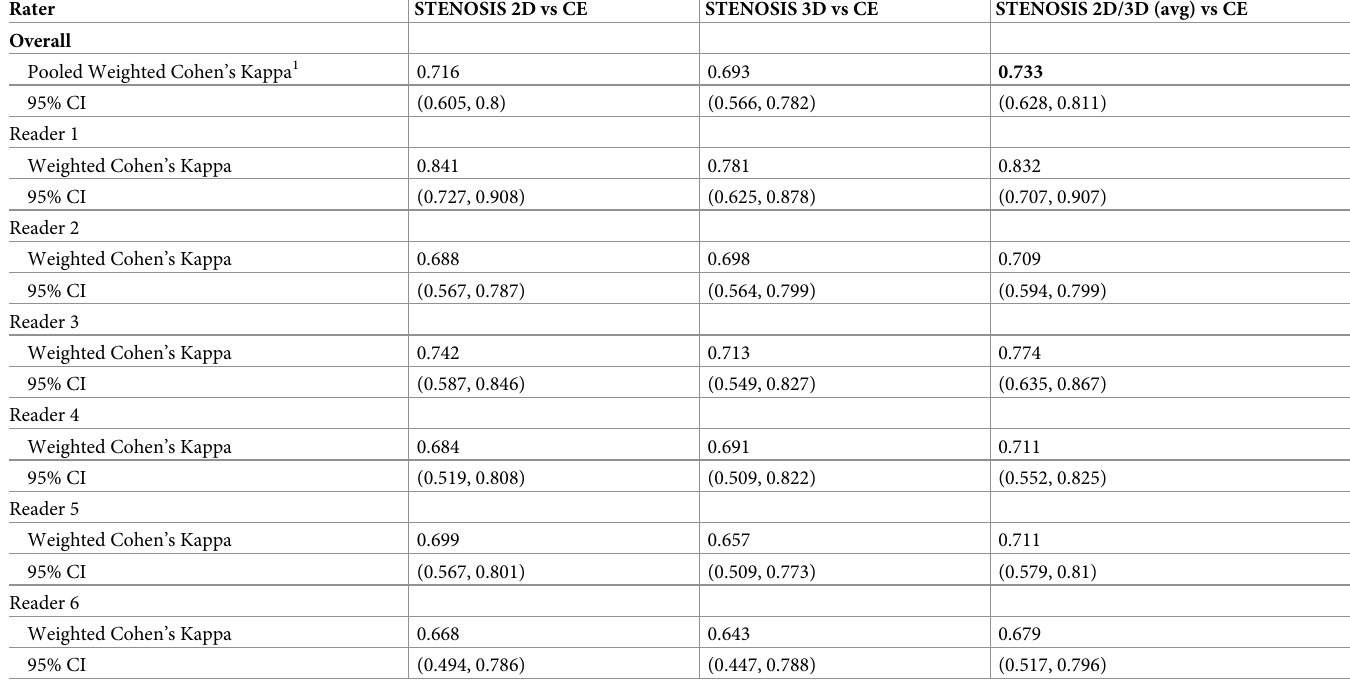
Table 3. Unenhanced vs enhanced